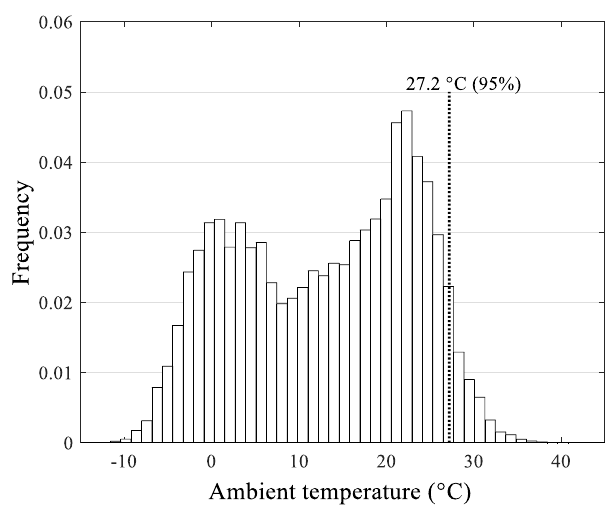
Figure 2. The frequency distribution histogram of ambient temperatures.